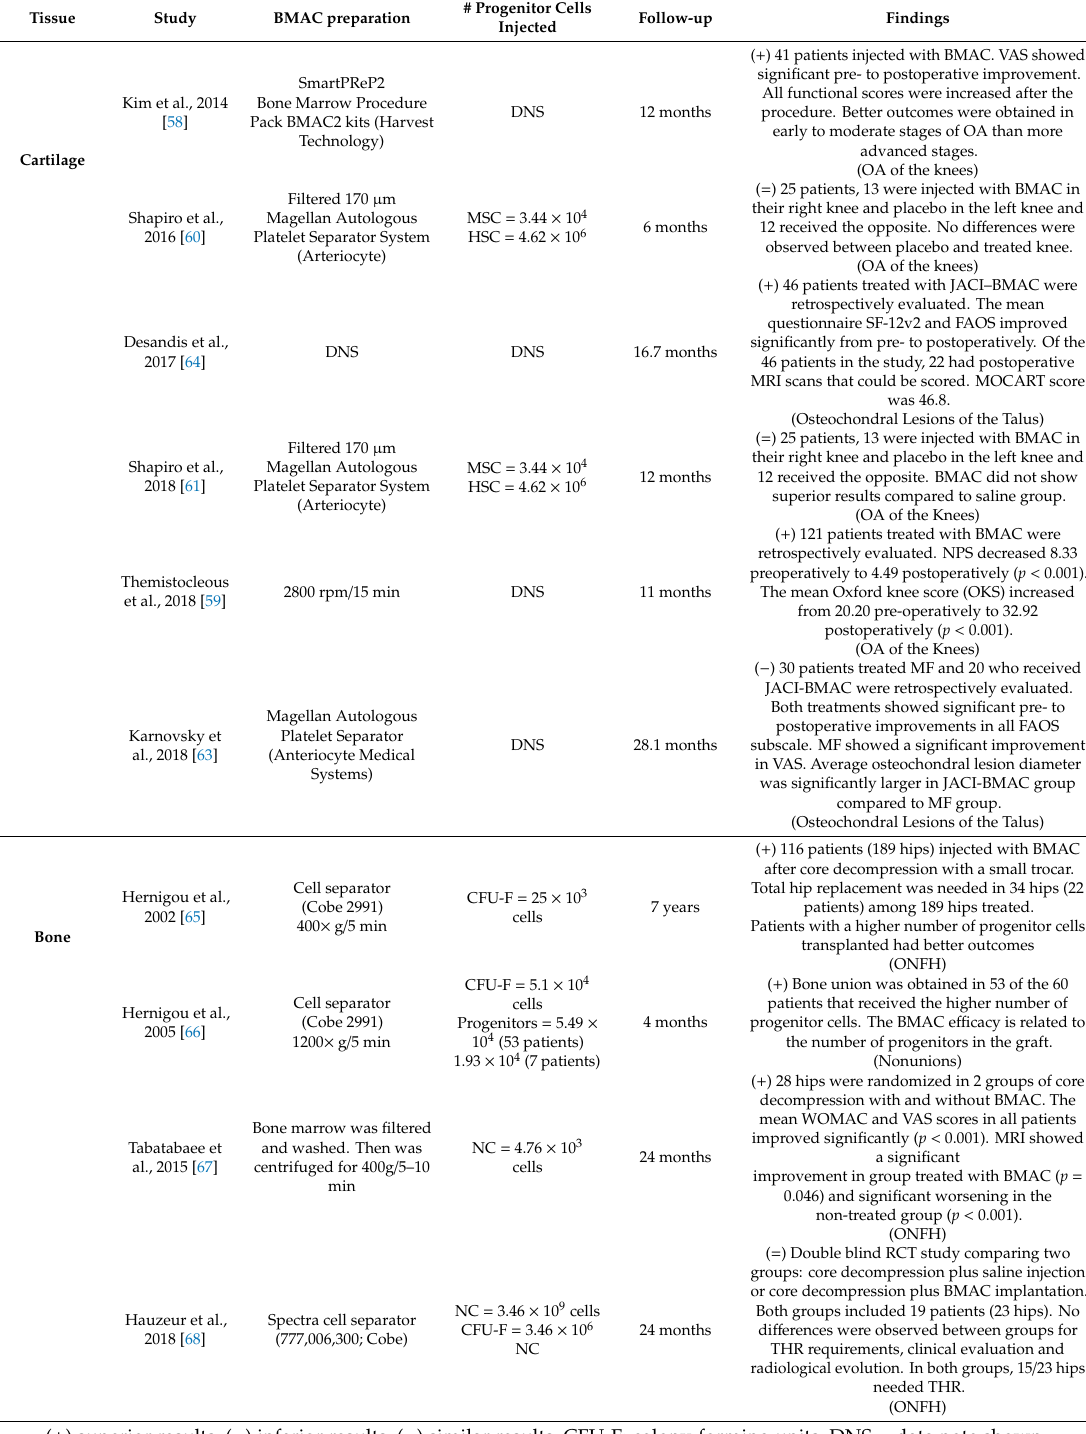
Table 2. Main findings of the use of bone marrow aspirate concentrate (BMAC) in clinical trials according to the tissue type.